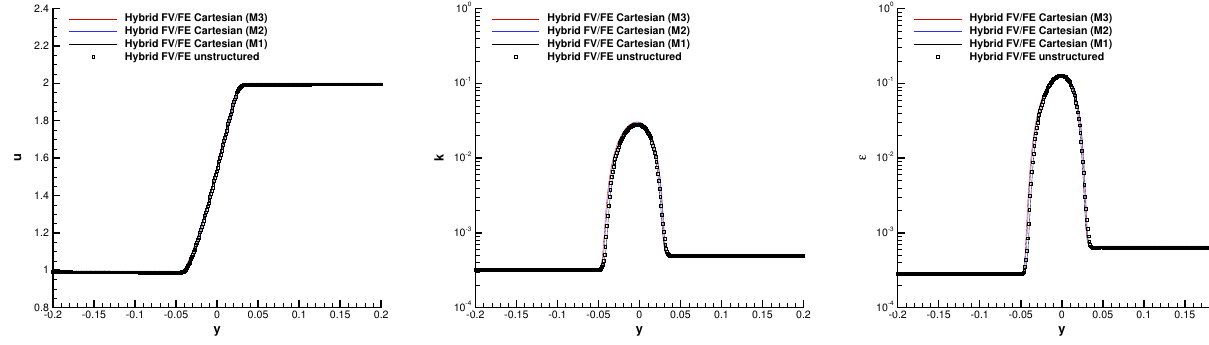
Figure 12. 1D cut through the planar mixing layer at time t = 10 at position x = 0.8. Vertical profiles of velocity component u ( left ), turbulent kinetic energy k ( center ) and turbulent dissipation ε ( right